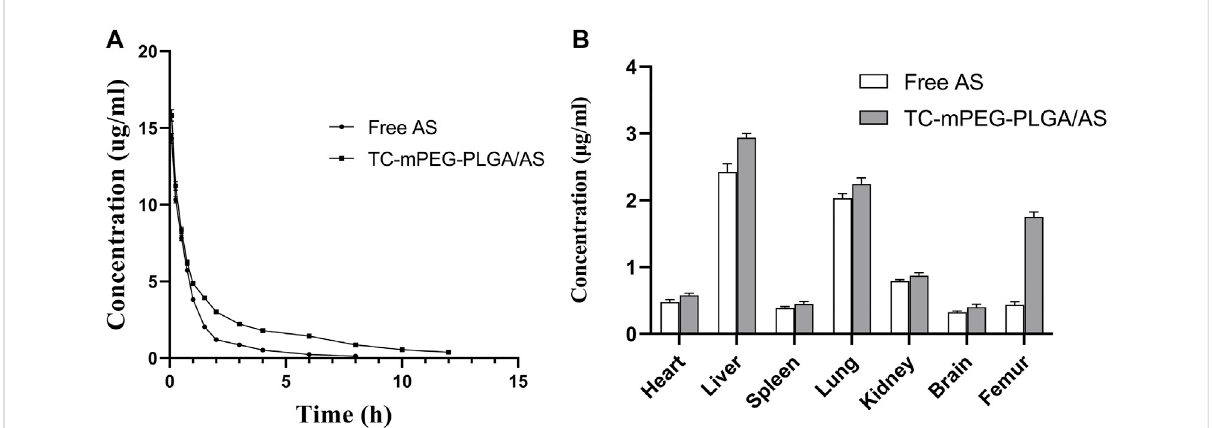
FIGURE 5 Concentrationtime pro fi les inplasma (A) andtissue distribution (B) offreeAS andAS-loaded TCgrafted mPEG ‒ PLGAmicelles. TC, tetracycline and AS, astragaloside IV.